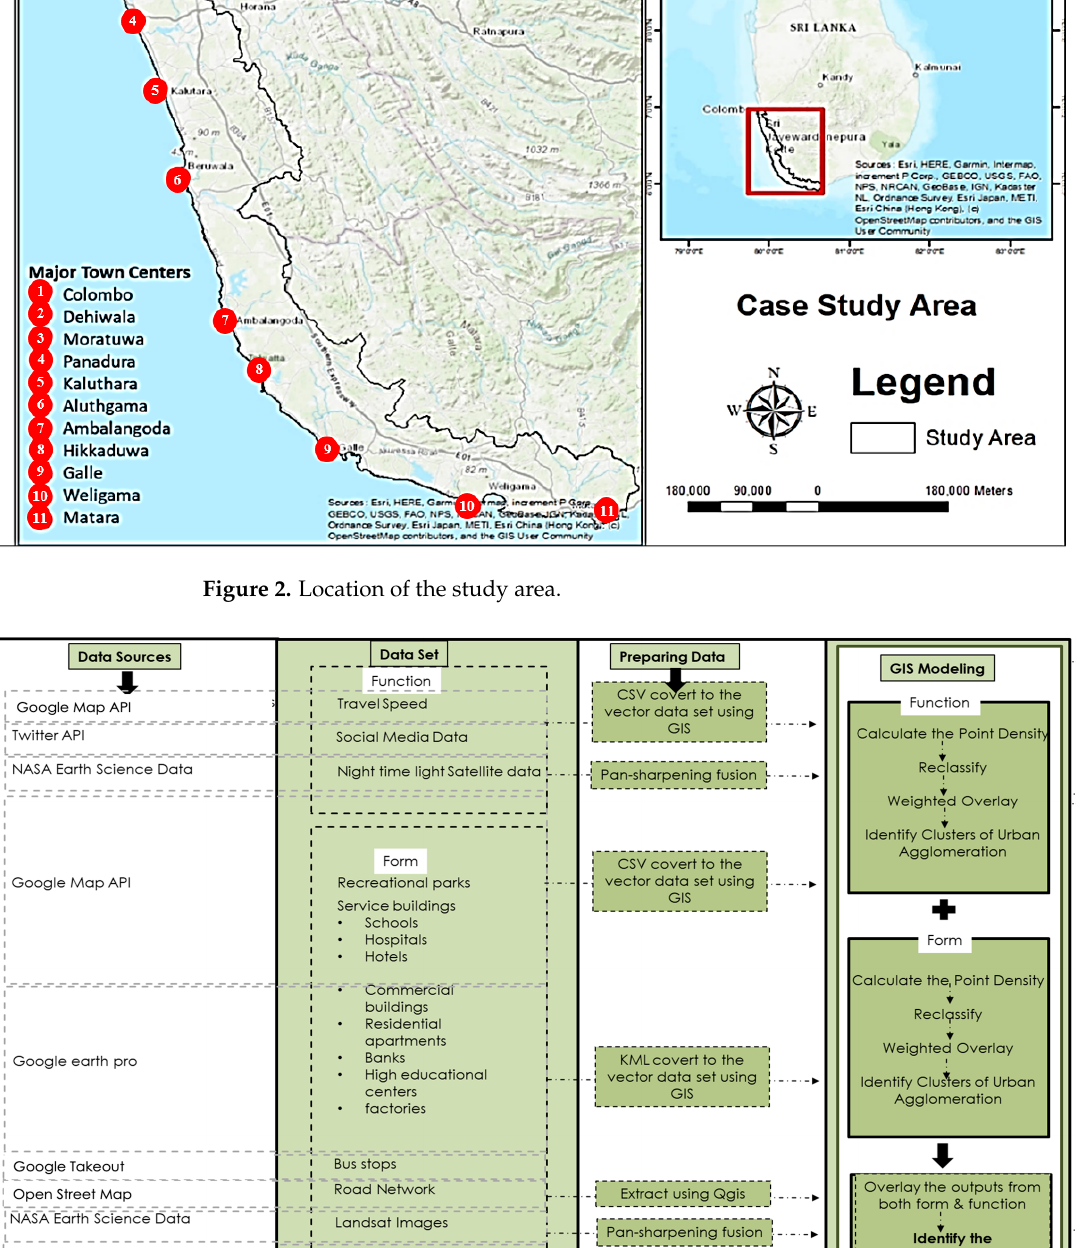
Table 2. Datasets and sources.